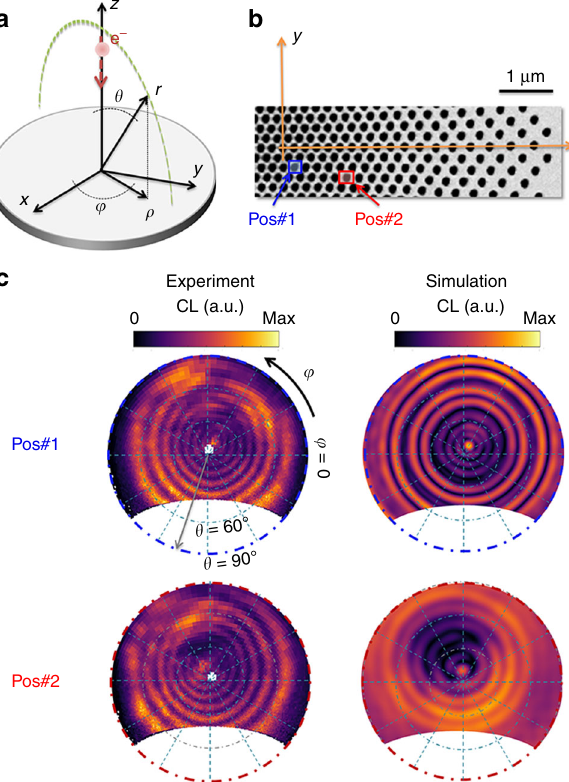
Fig. 5 Far- fi eld angle-resolved cathodoluminescence maps. a Detection geometry speci fi ed by the hemisphere positioned above the structure. b Impact positions for the electron beam, and c Experimental and simulated cathodoluminescence angular pro fi le at E = 1.9 eV, at two different electron impact positions for the incident electron marked by red and blue colors in